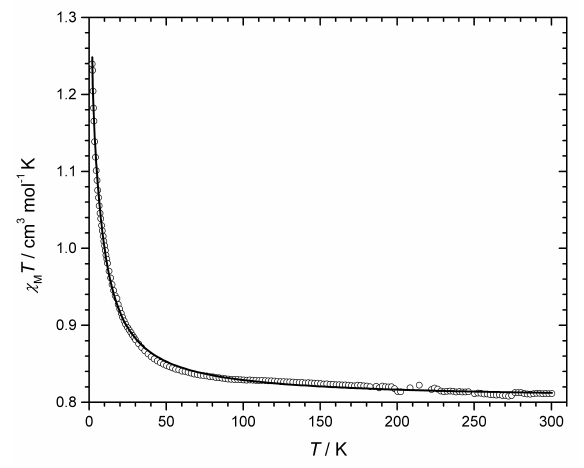
Figure 6. Temperature dependence of the χ M T product for 2 : ( ○ ) experimental; ( __ ) best-fit curve through equation (1) (see text).